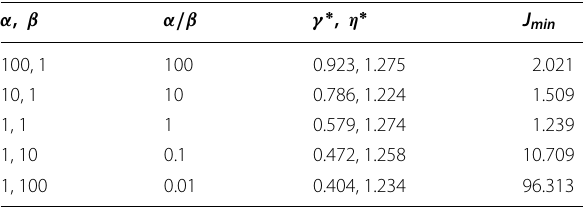
Table 1 Weighting factors & Optimal parameters & J